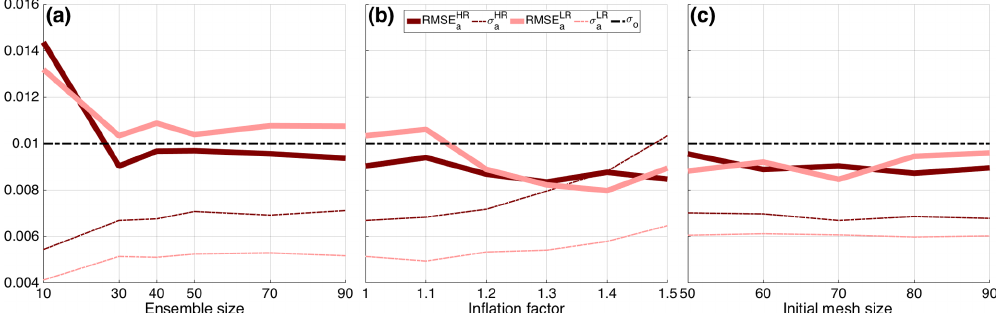
Figure 8. Time mean of the RMSE of the analysis ensemble mean (solid line) and ensemble spread ( σ ; dashed line) of BGM for different ensemble size, N e (a) , inflation factor, α (b) , and initial mesh size, N 0 (c) . Dark and light red lines show the HR and LR, respectively.